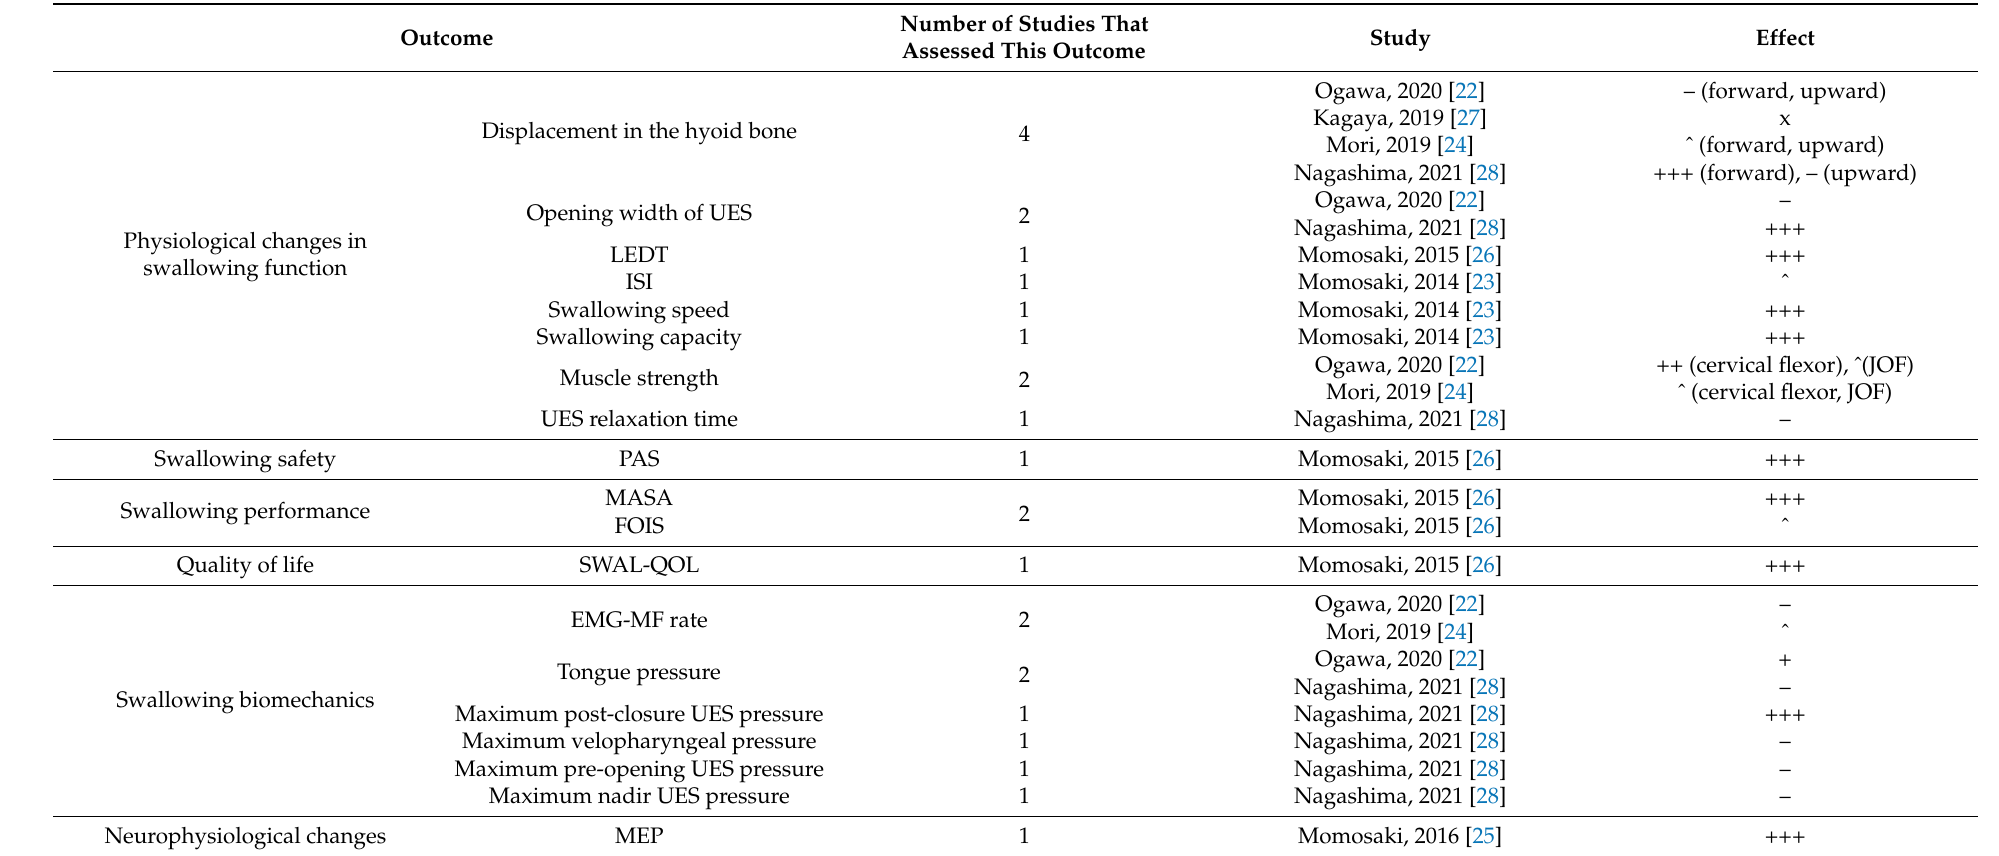
Table 3. Summary of selected